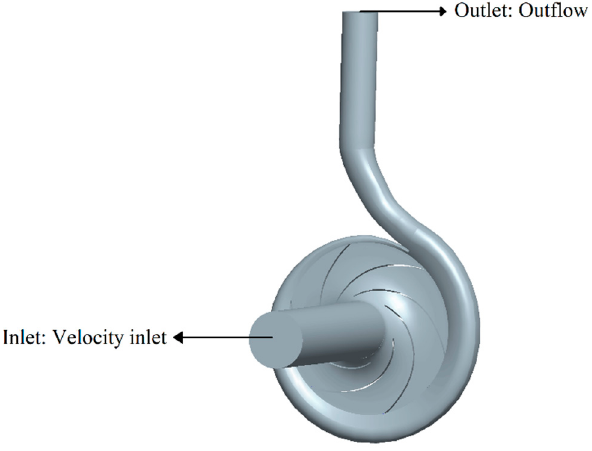
Figure 1. Sketch of the centrifugal pump model.